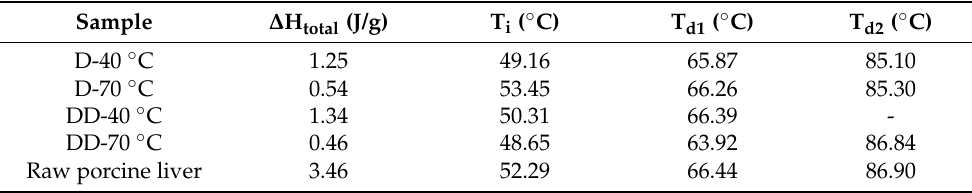
Table 4. DSC parameters (enthalpy of denaturation: ∆ H; initial temperature: Ti; denaturation points: T d1 and T d2 ) of porcine liver samples dried at 40 ◦ C (D-40 ◦ C) and 70 ◦ C (D-70 ◦ C), and subsequently defatted (DD-40 ◦ C and DD-70 ◦ C), reconstituted at 19.2% protein ( w / v ), as raw porcine liver.